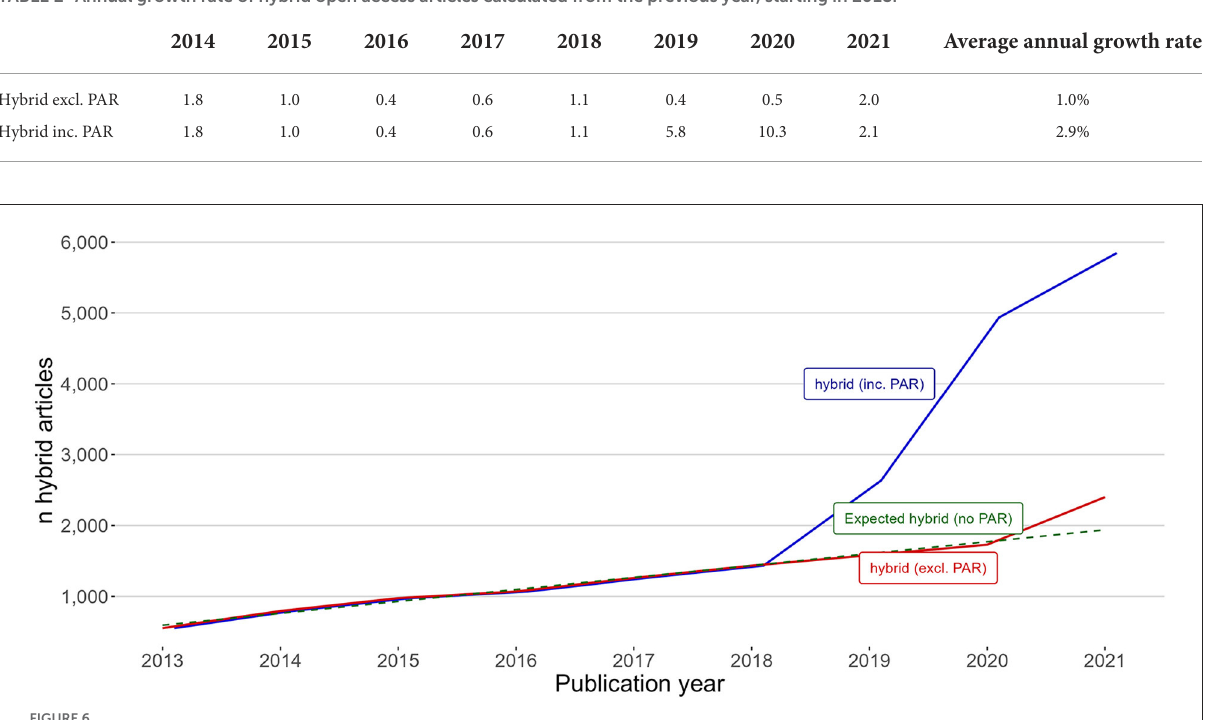
FIGURE6 All 10 Norwegian universities’ production of hybrid open access articles in the period 2013–2021, separated by hybrid inc. PAR hybrid (blue line) and hybrid excl. PAR hybrid (red line). The dashed green regression line indicates expected level of hybrid open access publications without the introduction of PAR deals. The prediction is based on 2013–2018 data.